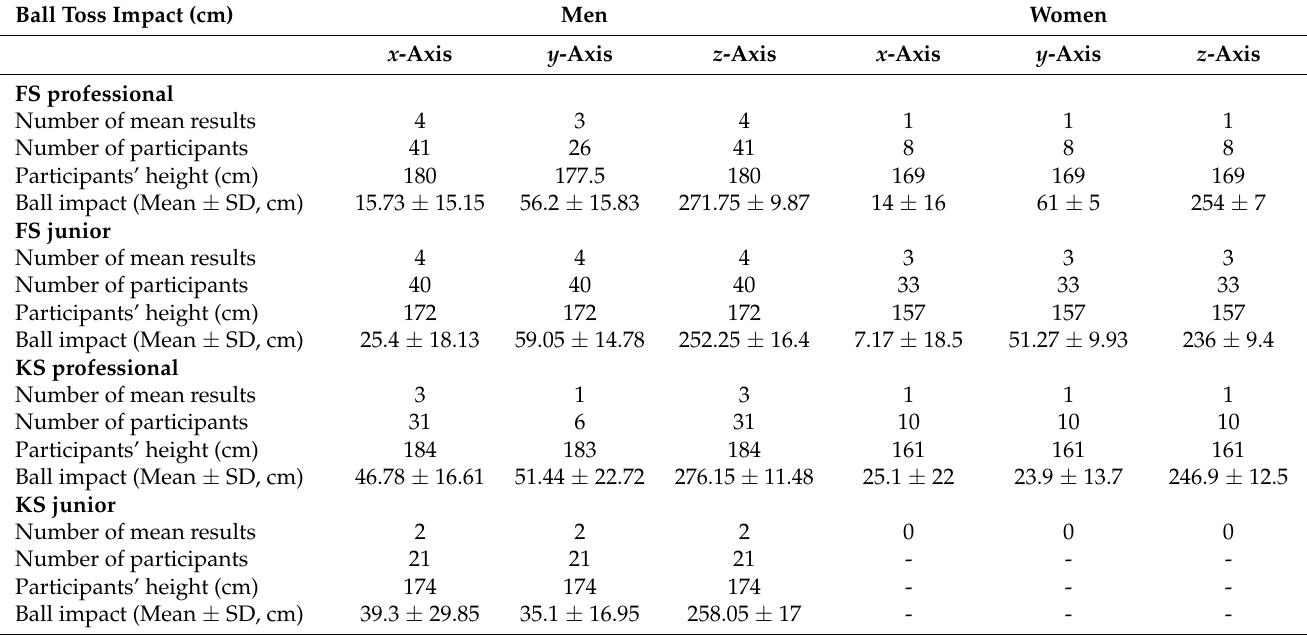
Table S2) of the BI location among the individual groups within FS; on the x -axis: the